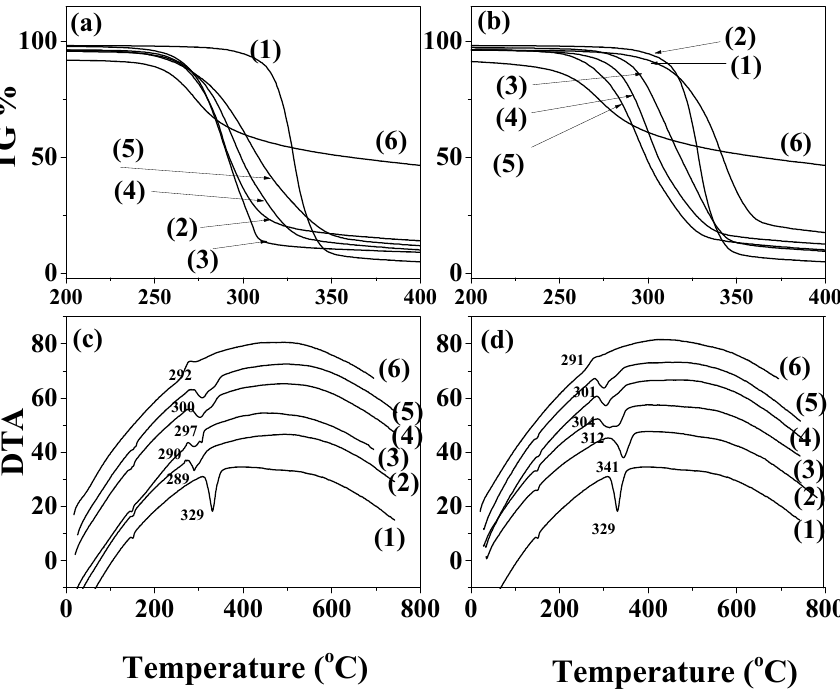
Figure 4. Thermogravimetric (TG) ( a , b ) and Differential Thermal Analysis (DTA) ( c , d ) plots of all PLLA/CS ( a , c ) and PLLA/CS/BO composite films as well as blank PLLA film, and pure CS and modified CS/BO powders: in Figure 4a,c (1) PLLA, (2) PLLA/CS5, (3) PLLA/CS10, (4) PLLA/CS20, (5) PLLA/CS30, and (6) CS are shown, and in Figure 4b,d, (1) PLLA, (2) PLLA/CS/BO5, (3) PLLA/CS/BO10, (4) PLLA/CS/BO20, (5) PLLA/CS/BO30, and (6) CS/BO are shown.